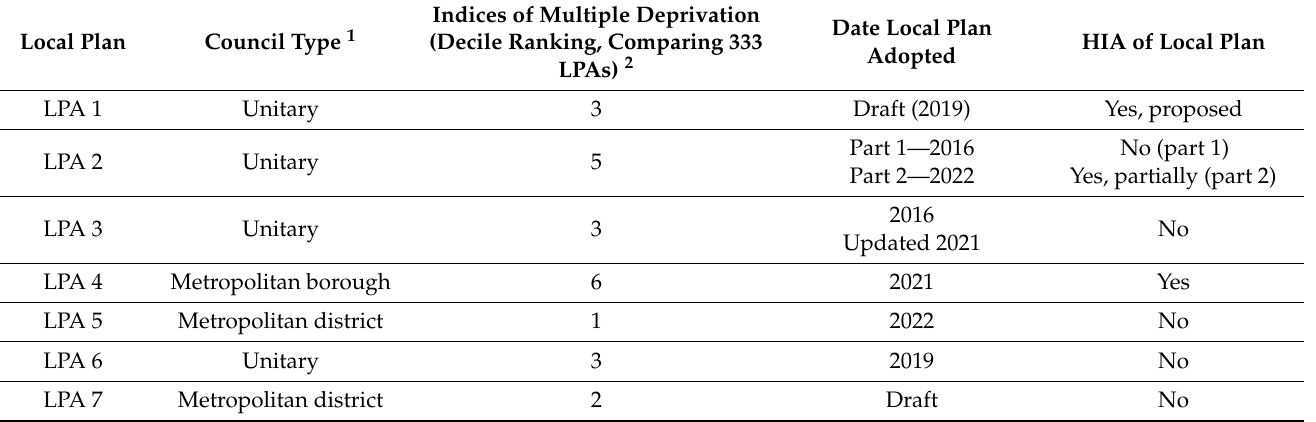
Table 1. Local plans included in the